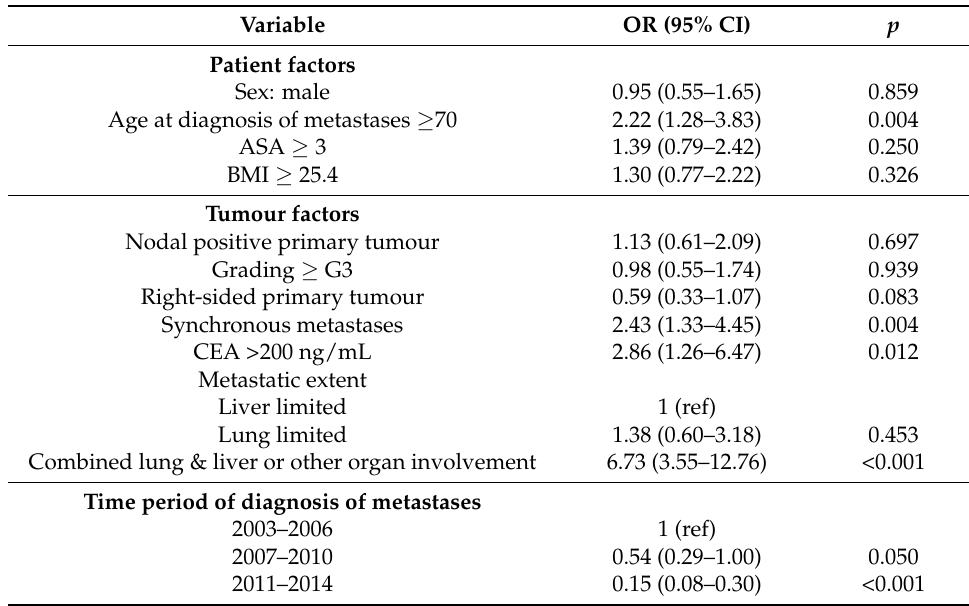
Table 5. Factors associated with palliative treatment decision (PAT; logistic